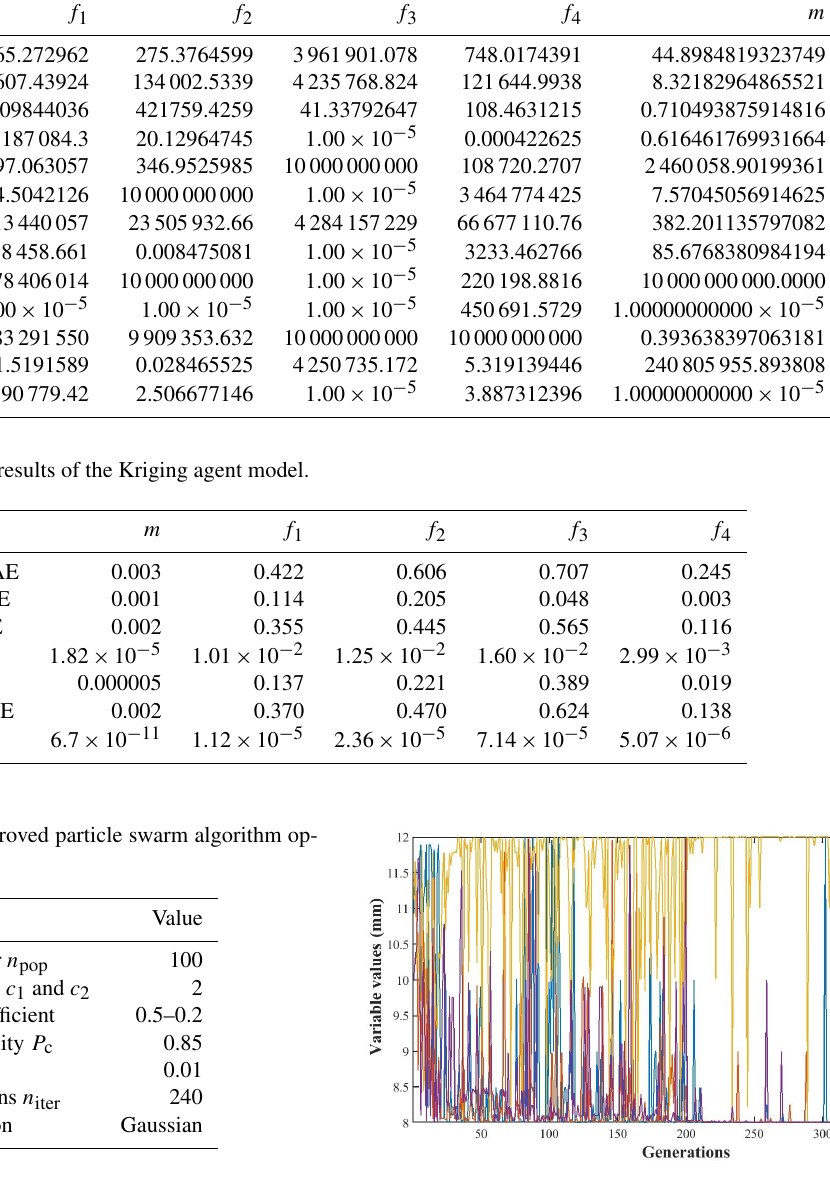
Figure 14. Variations of the design variables under different num- bers of